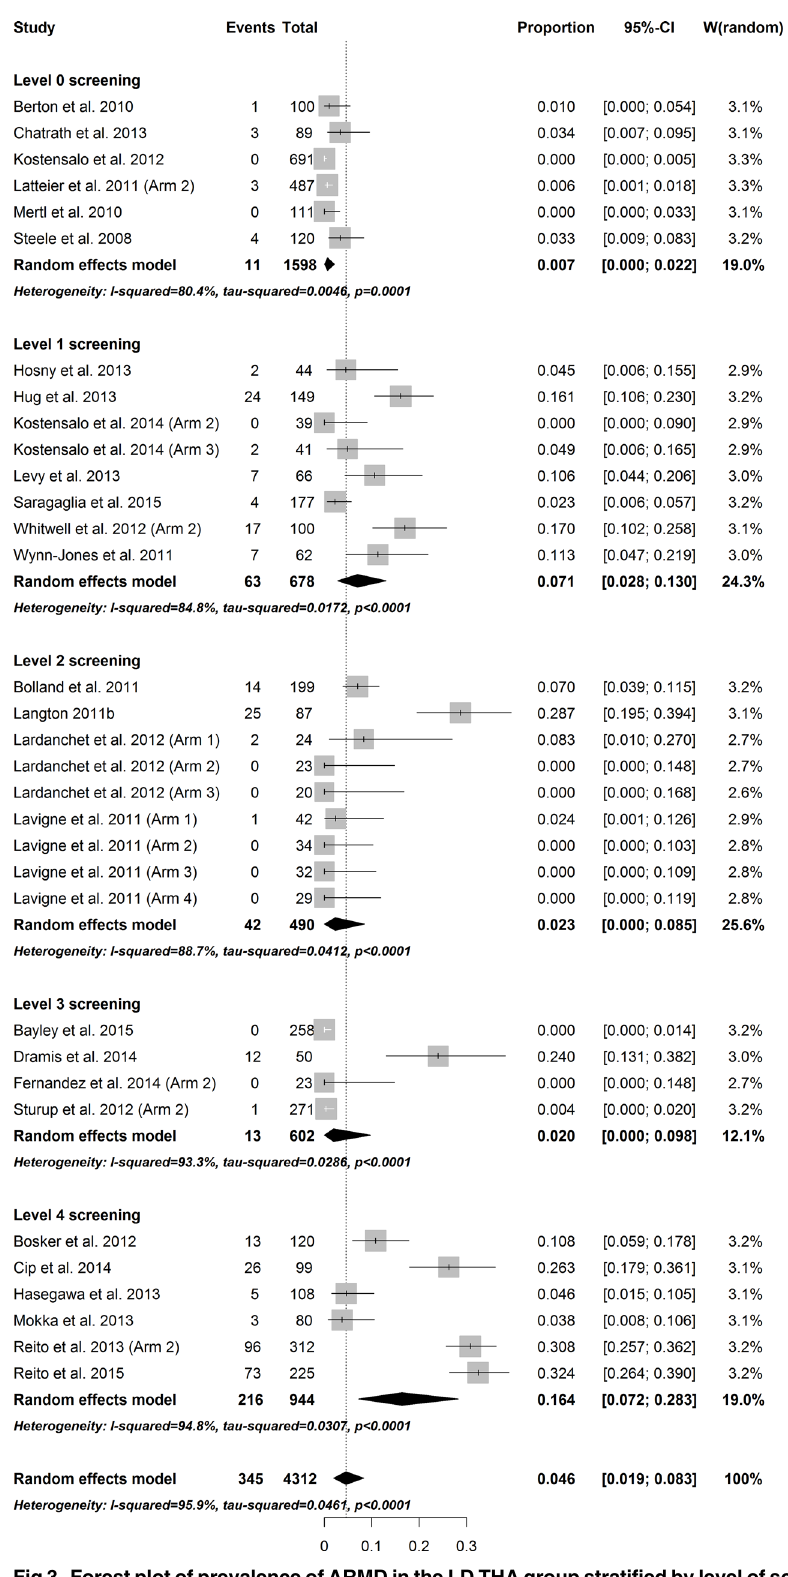
Fig 3. Forest plot of prevalence of ARMD in the LD THA group stratified by level of screening.